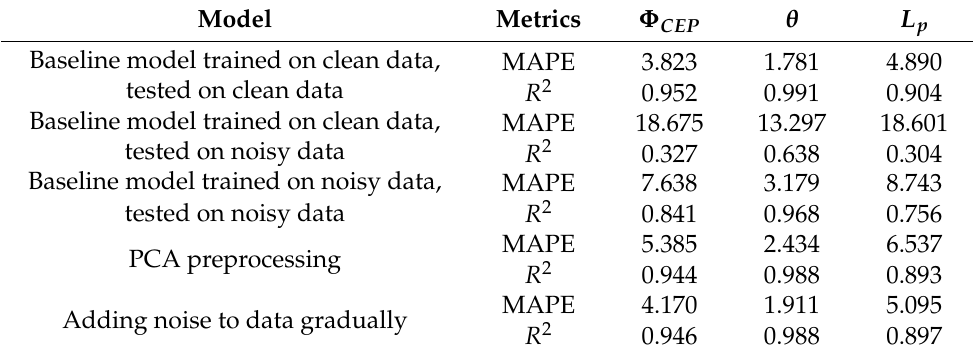
Table 2. Accuracy and coefficient of determination for reconstruction of parameters of laser–plasma interaction for the models trained on clean